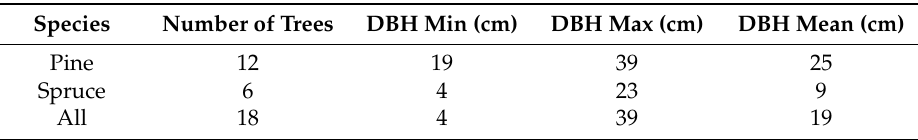
Table 1. Summary of tree diameter at breast height